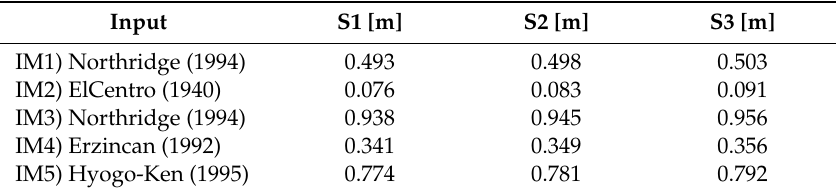
Table 6. Maximum displacements at the surface (z = 0.00